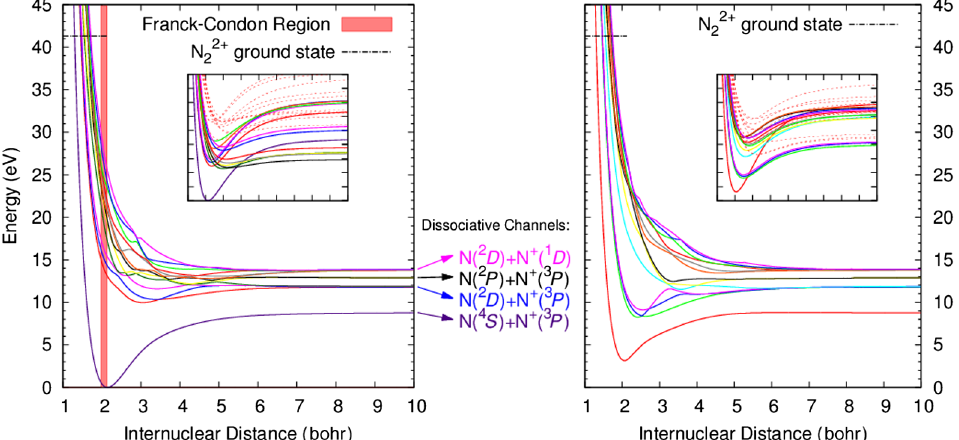
FIG. 11. Potential energy curves of symmetries including 2 Σ adiabatic states whose orbitals are optimized and the insets show the diabatic states used for propagation, including also some higher lying states (faint lines) obtained with the method outlined in Sec.